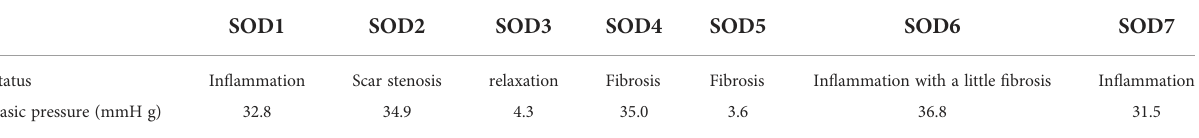
TABLE 1 Samples with sphincter of Oddi dysfunction.